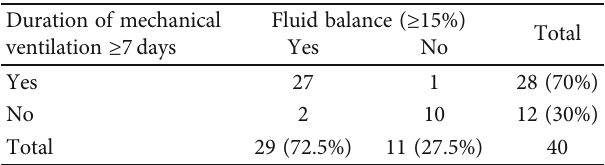
Table 3: Signi fi cance of association between PIM2 score and prolonged